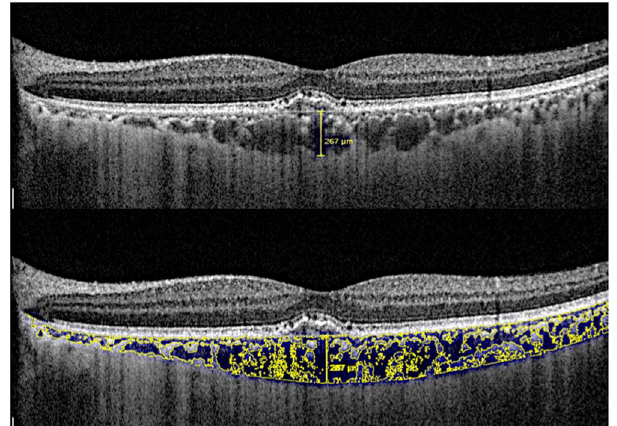
Figure 1. The measurement of subfoveal choroidal thickness (top) and choroidal vascularity index (bottom) using image binarization technique and Image